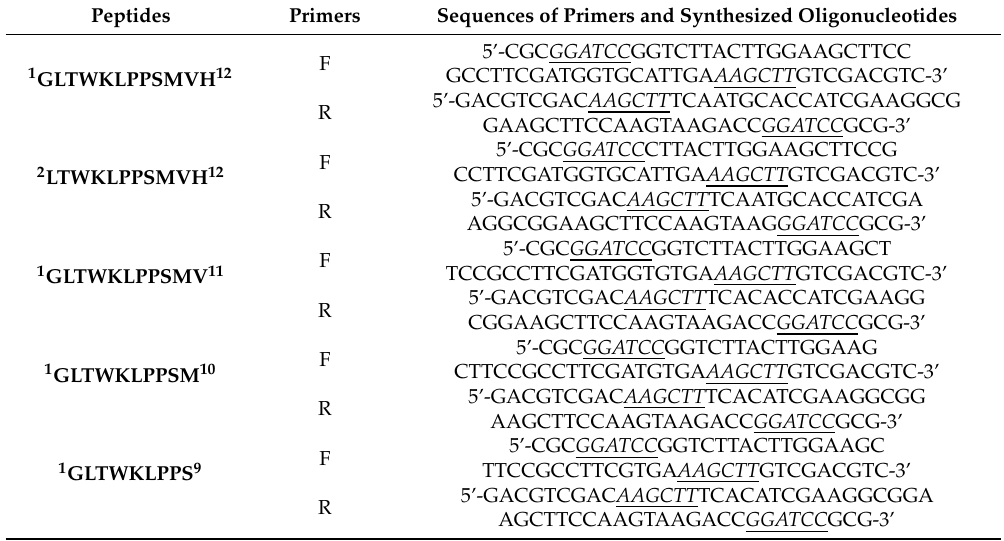
Table 1. Primers used for the epitope identification. Peptides Primers Sequences of Primers and Synthesized